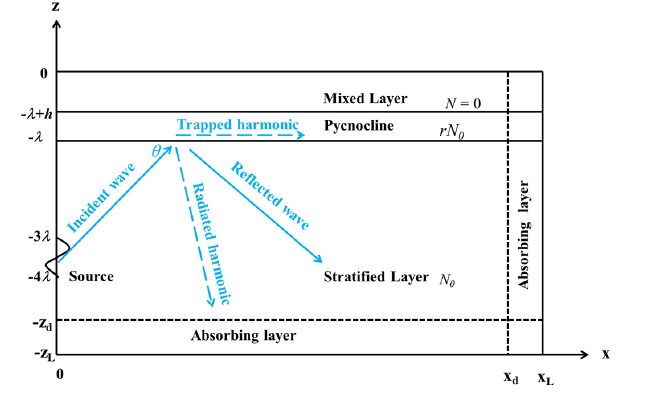
Table 1. Simulation